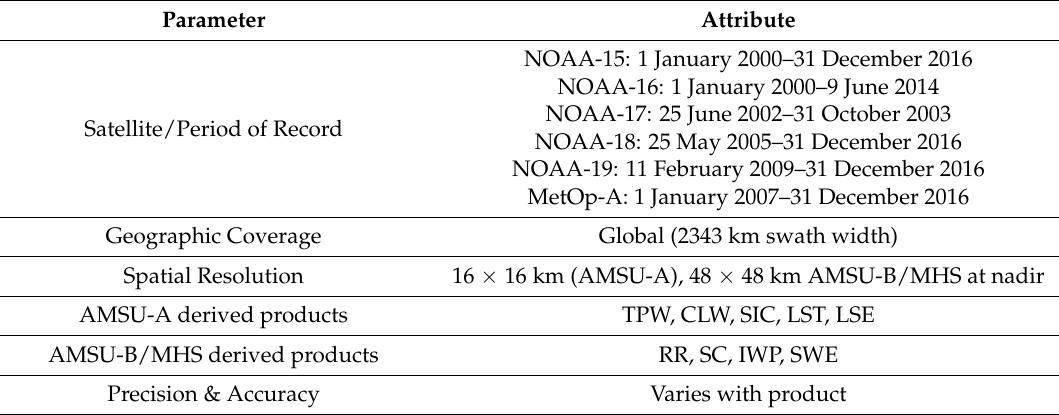
Table 1. AMSU-A/B/MHS L2 product attributes. Products listed include total precipitable water (TPW), cloud liquid water (CLW), sea-ice concentration (SIC), land surface temperature (LST), land surface emissivity (LSE), rain rate (RR), snow cover (SC), ice water path (IWP), and snow water equivalent (SWE).